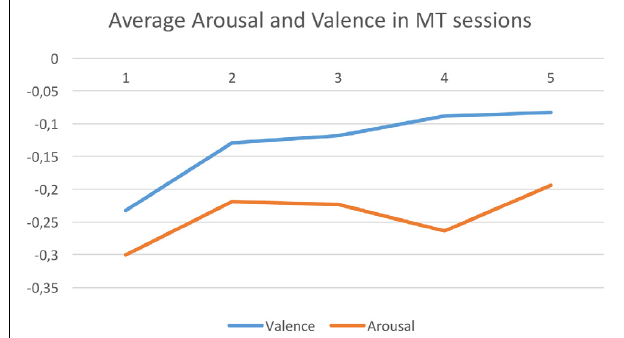
FIGURE 4 | Experimental group averaged arousal (Orange) and valence (blue) levels along time. 1 = beginning, 2 = receptive song, 3 = active song, 4 = receptive imaginative intervention, and 5 = end of session.